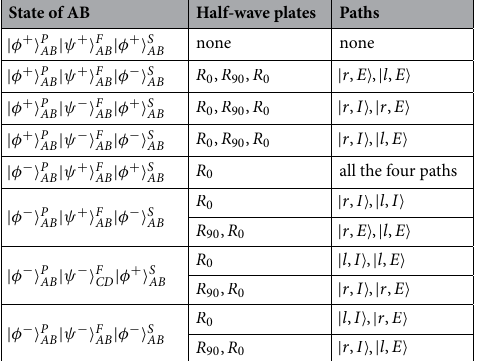
Table 3. The relation between the states of photon pair AB , the half-wave plates and the relevant paths.